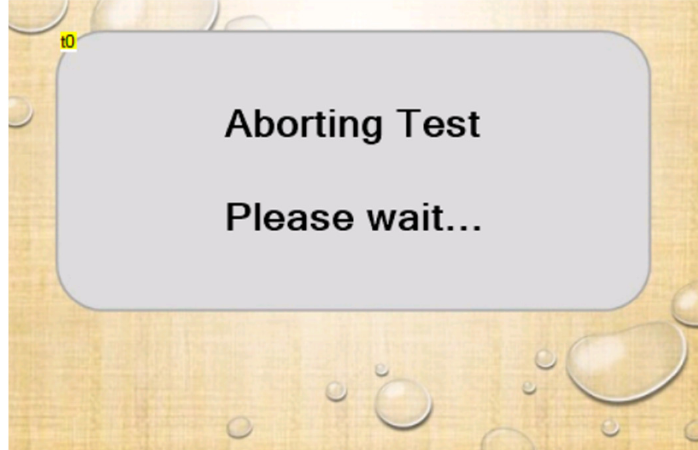
Figure 5. Test abort page.